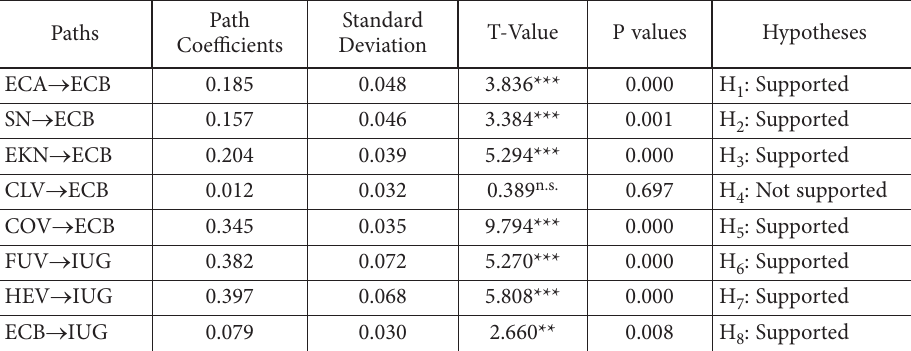
Table 4. The path coefficients of the structural equation